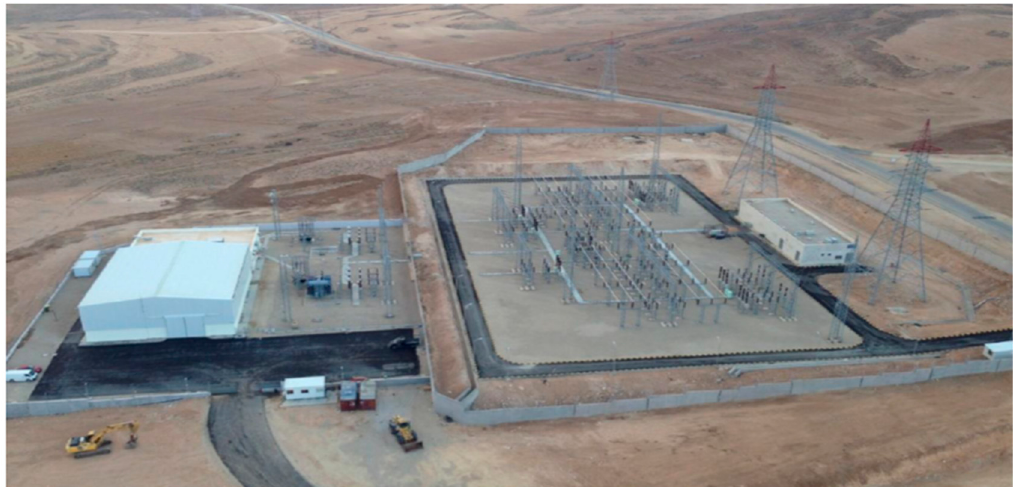
Figure A3. Image of the substation.